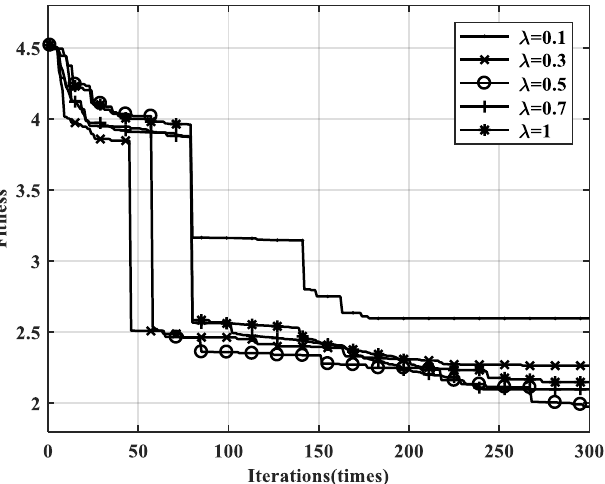
Figure 16. Impacts of different regularization factors on the fitness error of the TVIPSO inversion.